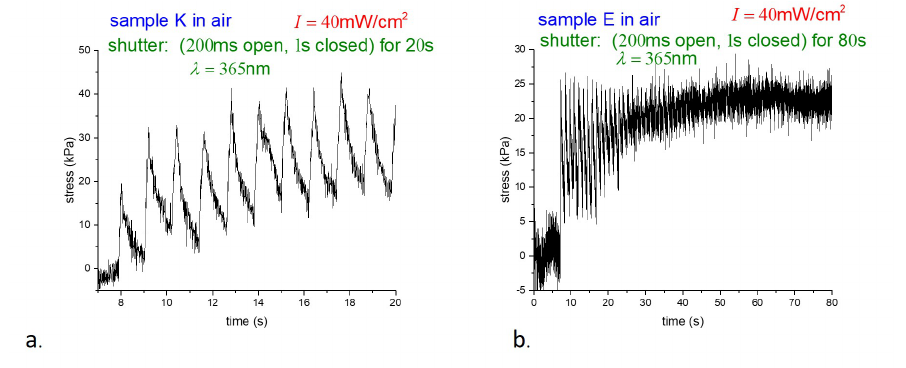
Figure 4. Schematic of experimental setup for photostress measurement.